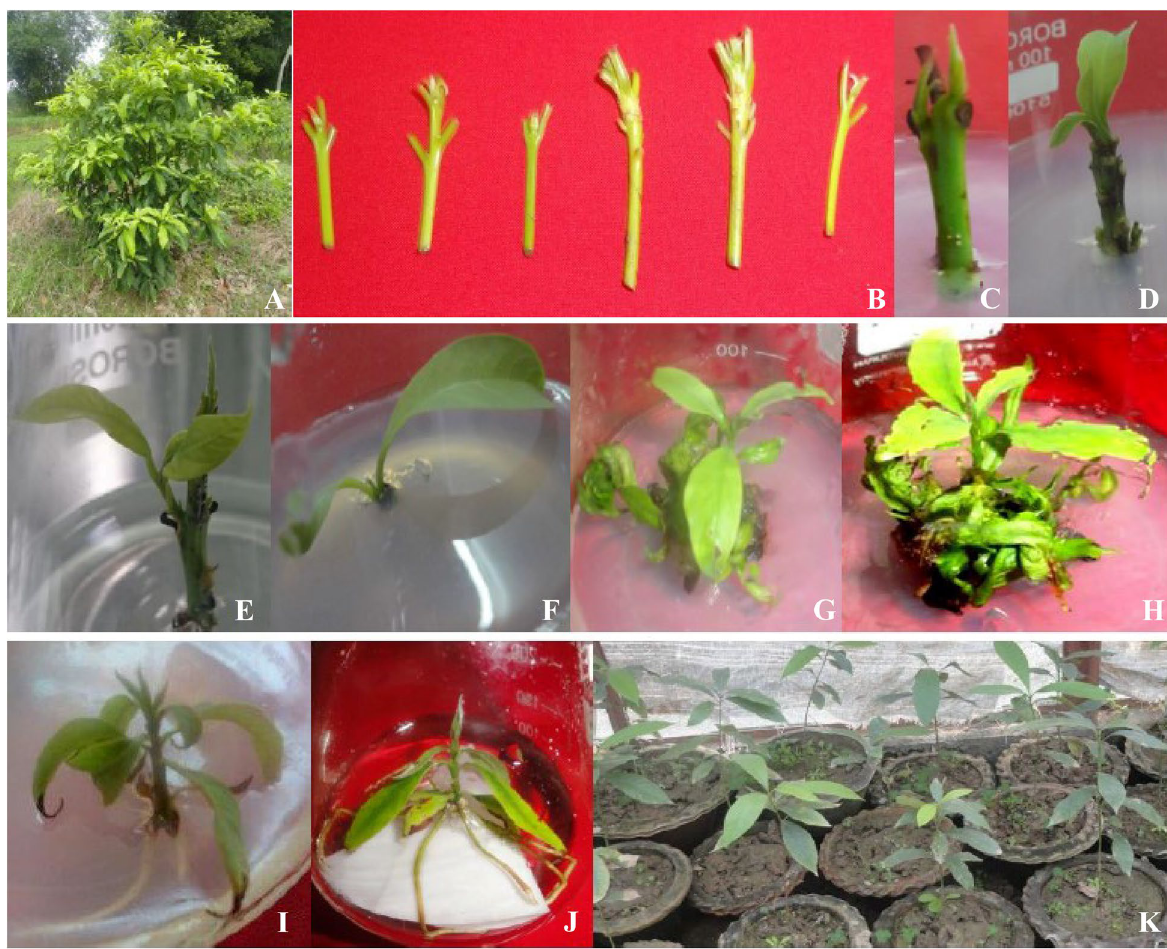
Fig. 1 In vitro propagation of Phoebe goalparensis . A Mother plant. B Preparation of explants material. C – F Emergence of shoot buds. G , H Shoot multiplication. I Root induction. J Hardening. K Acclimatization and soil